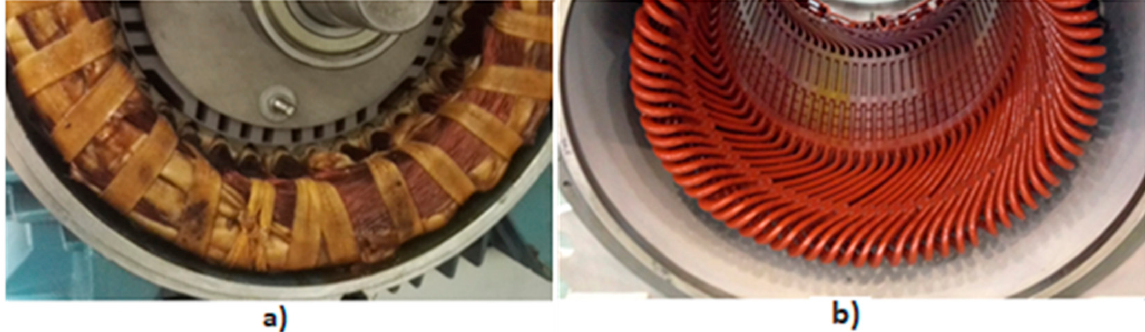
Figure 4. End windings: ( a ) conventional strand configuration, ( b ) form-wound configuration [5].